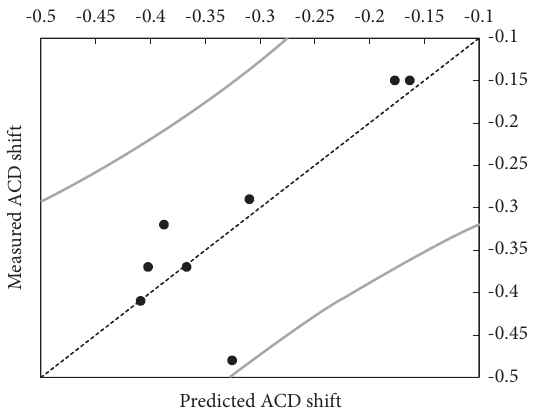
Figure 4: Correlation between the predicted pilocarpine-induced ACD shift using formula (1) and the really measured ACD shift in mm. The curved lines represent the 95% confidence